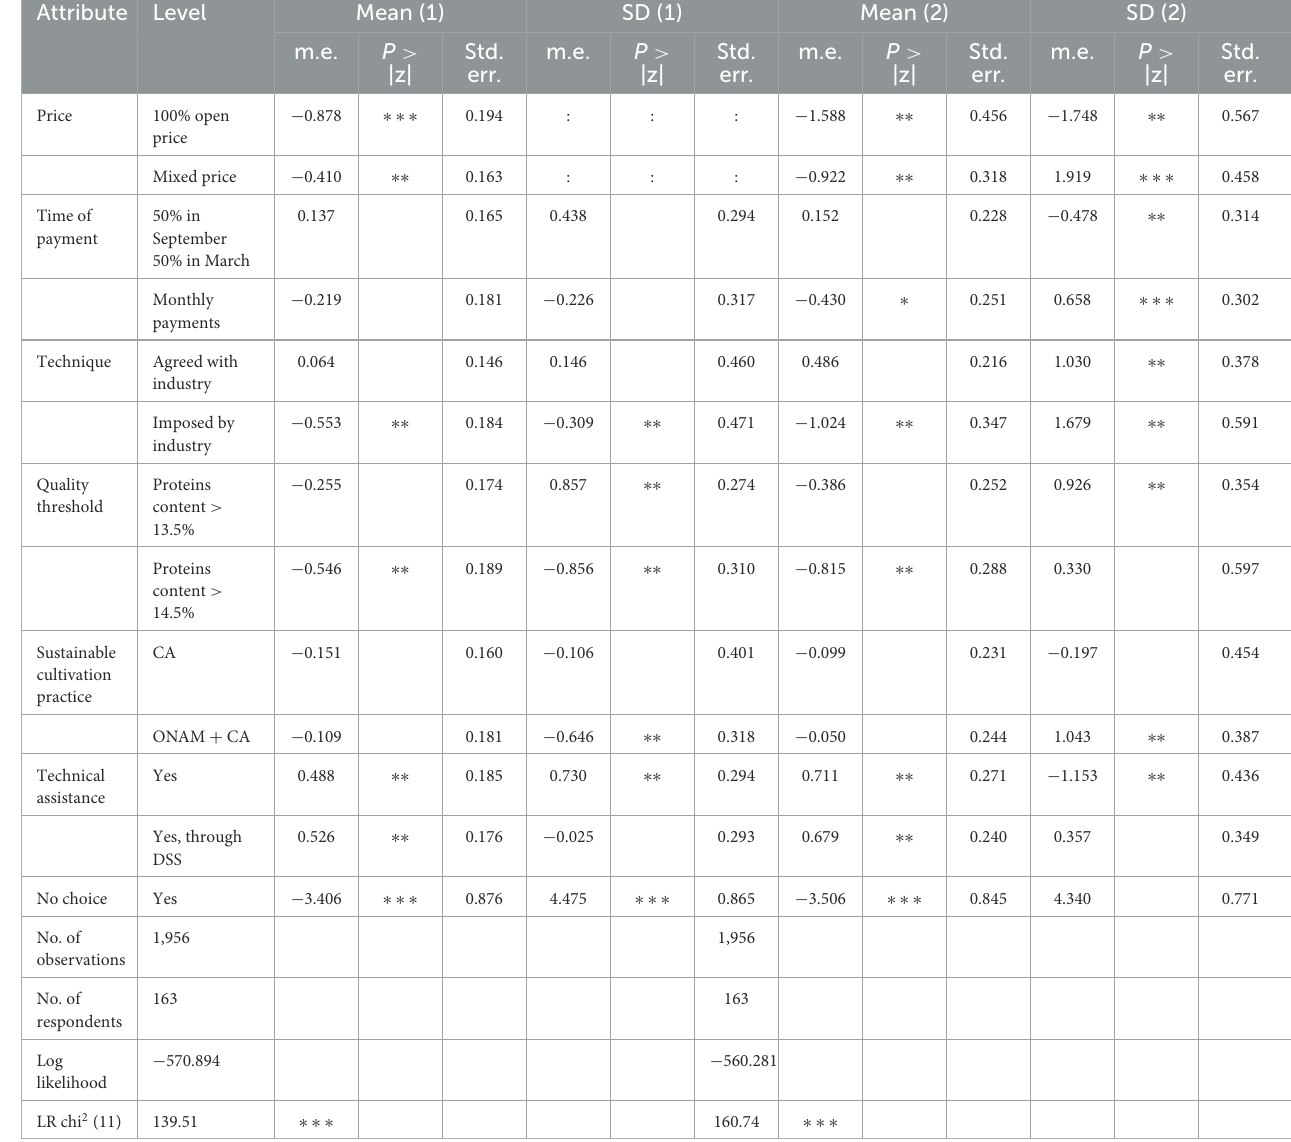
TABLE 4 Parameter estimates for the mixed logit models 1 and 2: marginal effects (m.e.). Attribute